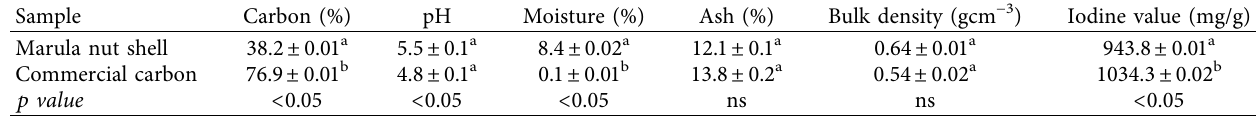
Table 4: Physicochemical properties of Marula nutshell and commercial carbon.